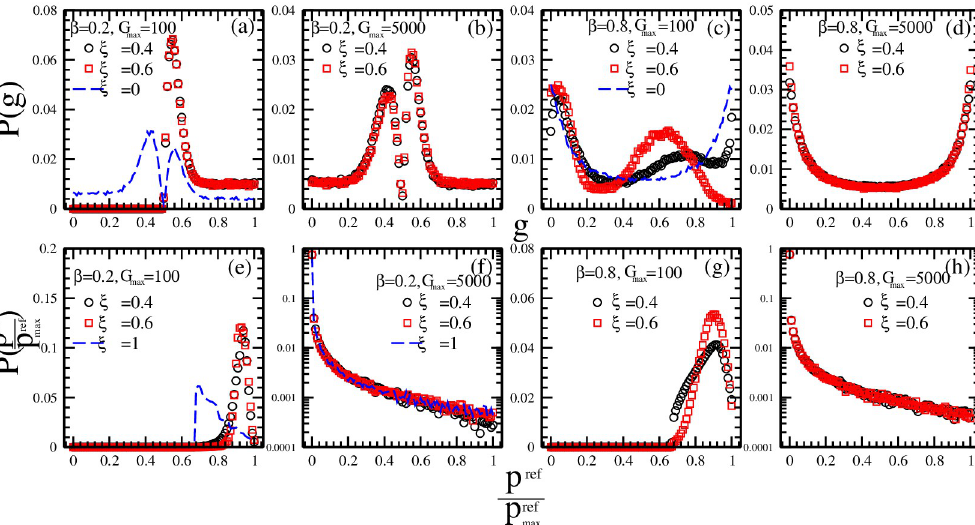
Fig 5. The distributions of history-dependent strategies (a, b, c, d) and reference point strategies (e, f, g, h) for different combinations of market impact β , maximal risk tolerance G max of reference point strategies and ratio ξ of individuals with reference point strategies. (a) and (e) β = 0.2, G = 100 and ξ = 0.4 (circles), 0.6 (squares); (b) and (f) β = 0.2, G = 5000 max max and ξ = 0.4 (circles), 0.6 (squares); (c) and (g) β = 0.8, G max = 100 and ξ = 0.4 (circles), 0.6 (squares); (d) and (h) β = 0.8, G max = 5000 and ξ = 0.4 (circles), 0.6 (squares). Other parameters are: the population size N = 5001, the memory size m = 3 and m 0 = 10, the updating threshold of history-dependent strategies S th = 0, the maximum drift of history-dependent strategies ε